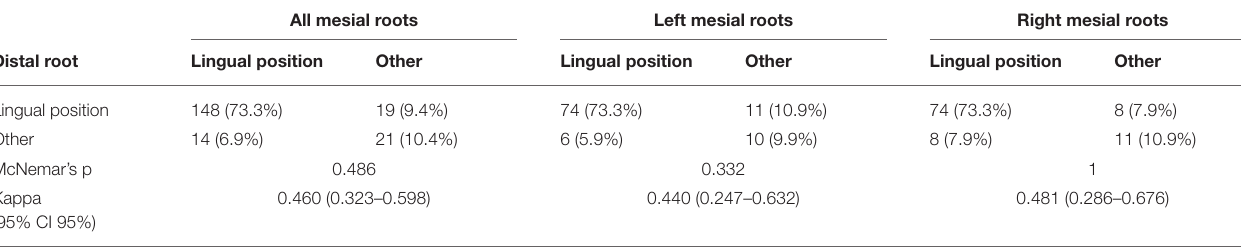
TABLE 1 | Summary of lingual position of root pairs within each tooth. All mesial roots